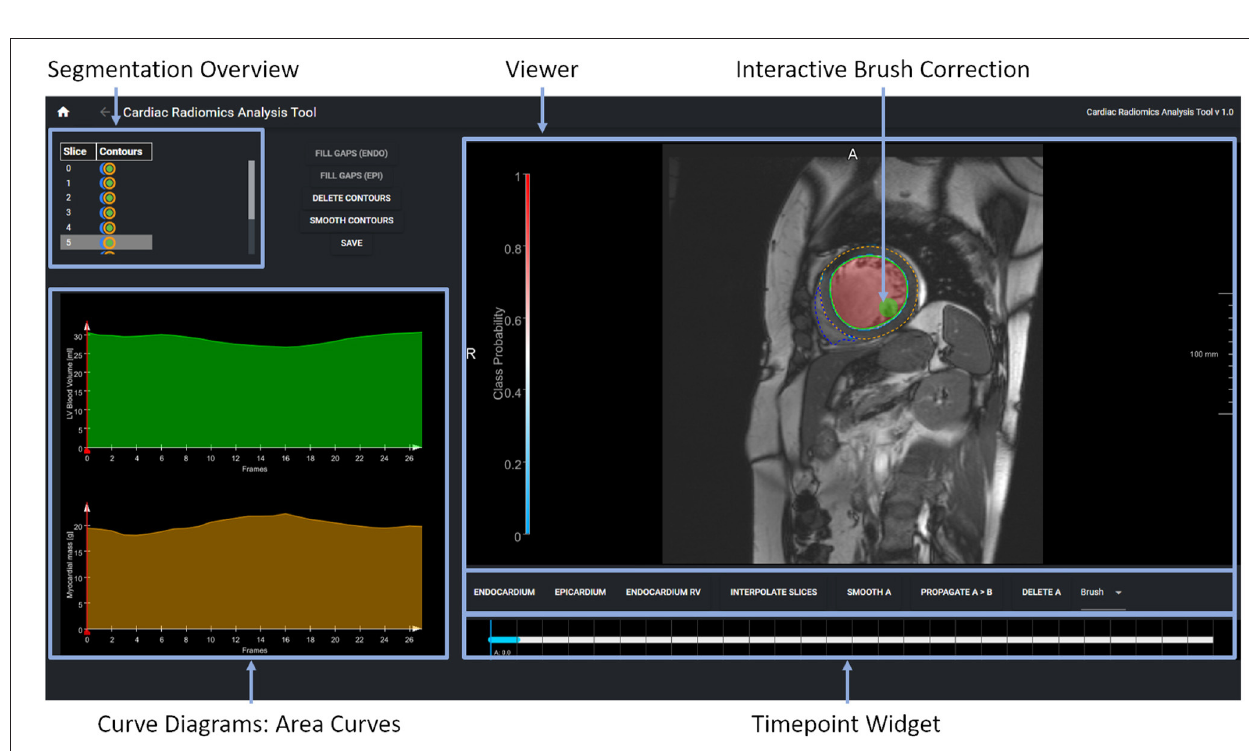
FIGURE 5 | The expert segmentation correction tool shows the segmentation results as contour overlay in the image viewer. The brush tool is visualized as a circle. The table in the upper displays the segmentation status per image slice and anatomical structure. The curve diagrams on the bottom left show the area curves and the segmentation algorithms’ probability of the segmentation results on the current slice.